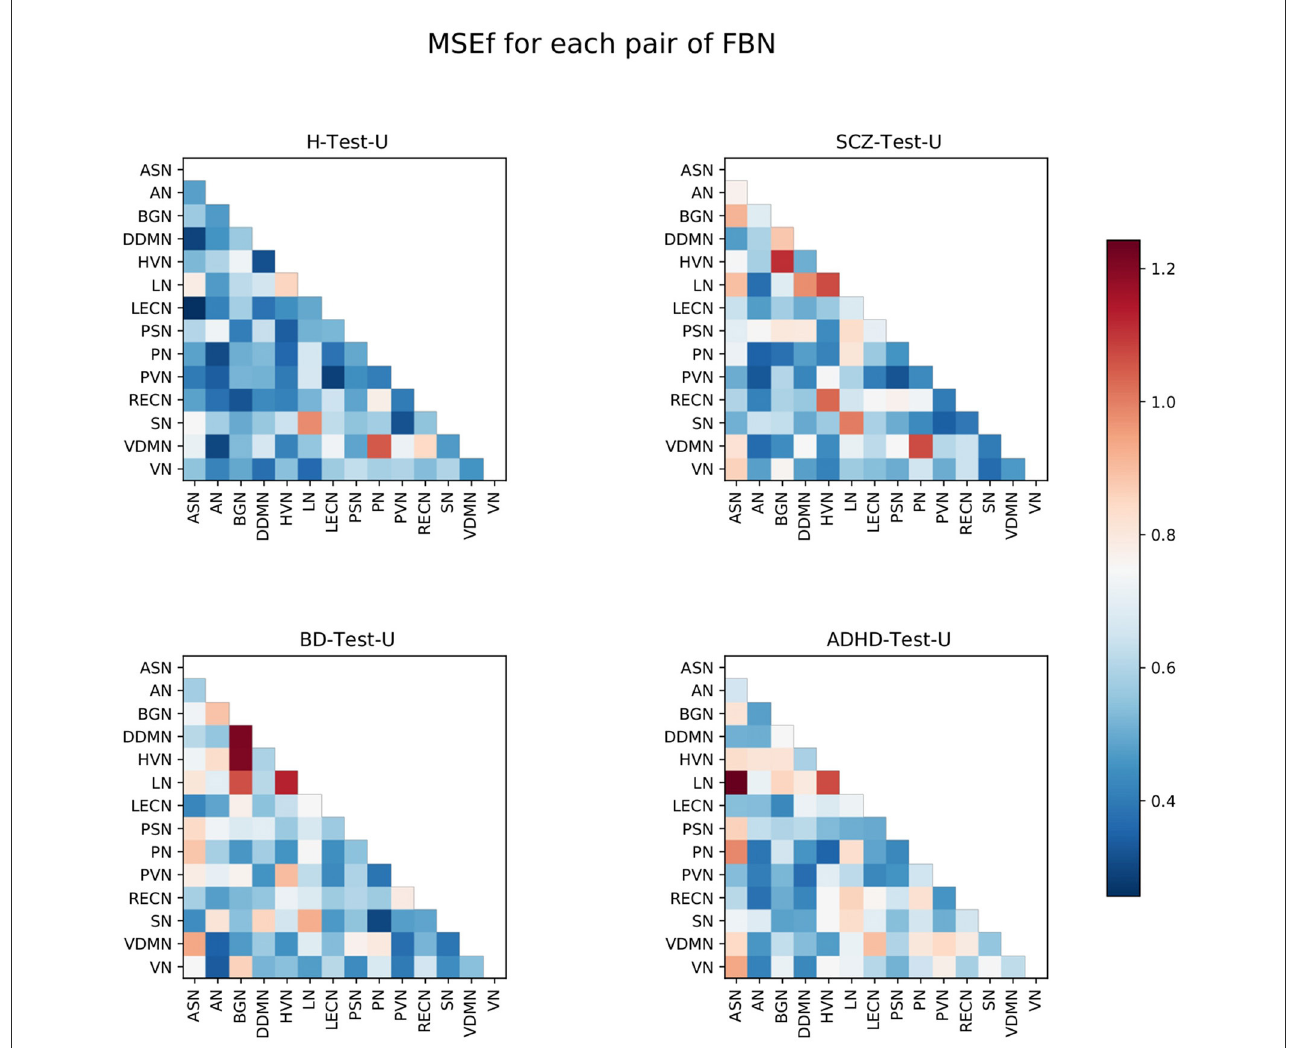
FIGURE3 Matrices representing the MSE f for each pair of FBNs, for the four test sets. The color bar ranges between the lowest and the highest values from the MSE f for each pair of FBNs of all test